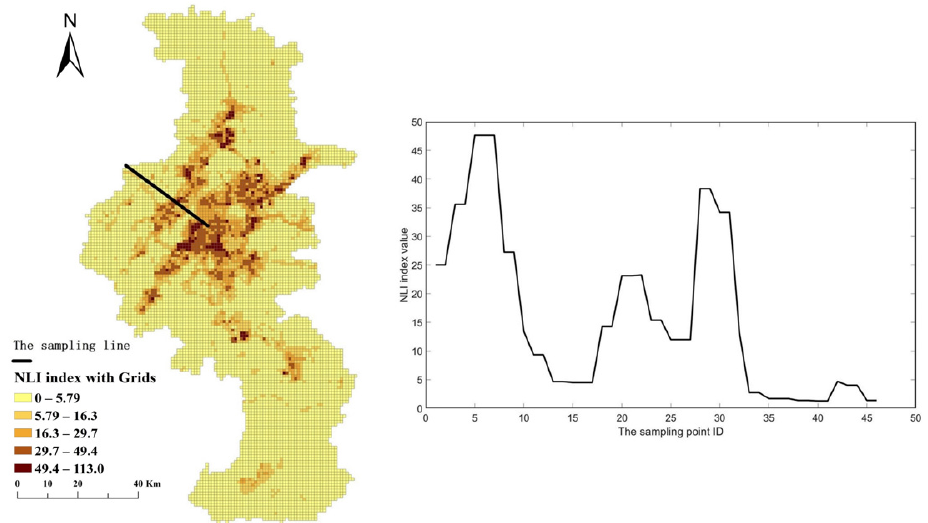
Figure 7. NLI index space sequence curve of the sampling line. Then, each signal’s mutation points (its highest and smallest scores) are detected through the approach called SCWT with the optimum scale (i.e., Scale a = 2) and wavelet basic function processed by db1 in Section 2.2.2. After mapping the points of mutation identified utilizing the entire as points, the model further eliminates “pseudo” mutation points using two standard deviation values. Ultimately, 473 mutation points were identi- fied in the center with many intersection points (Figure 8). Figure 8. Mutation points mapping result. 3.2. Urban Fringe Identification In the first step, Delaunay triangulation is presented to establish spatial proximity between the mentioned detected mutation points in Section 3.1, and their neighbor